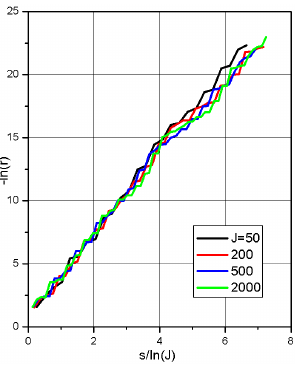
Figure 1. 5-solver, 5-scheme, Dirichlet. Figure 2. 9-solver, 9-scheme, Dirichlet.